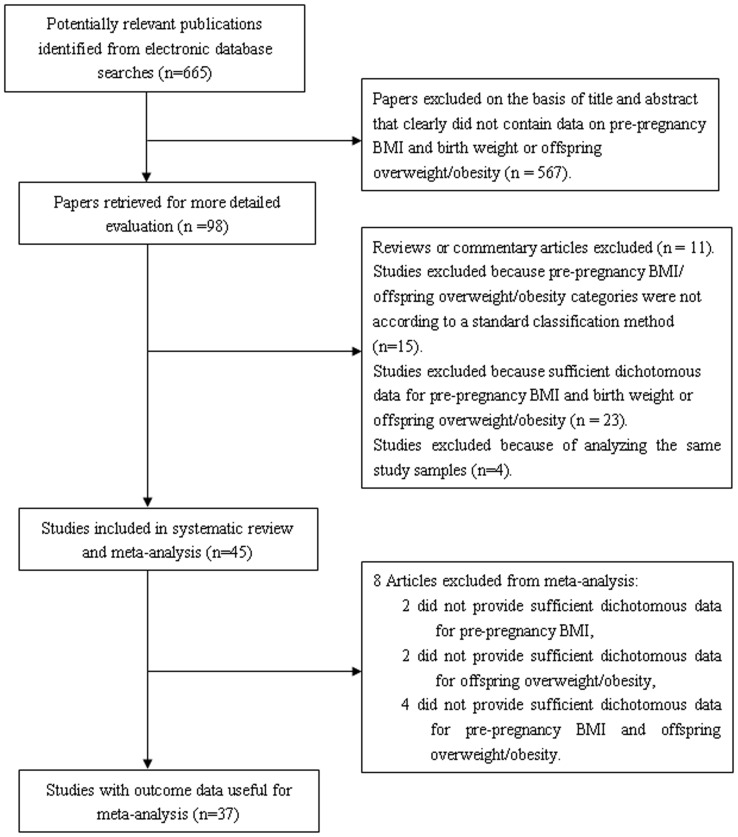
Screening and selection process for articles.